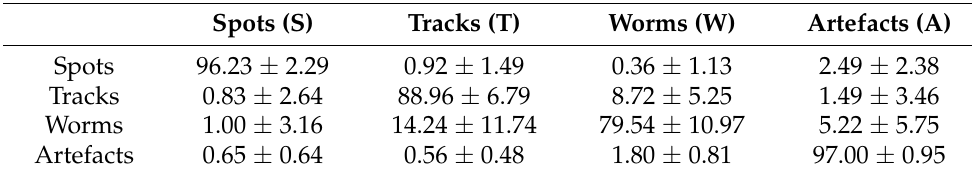
Table 9. Confusion matrix of the network with input VGG16 and threshold schema (8) t = 0.75. Data remaining = 74.26 ± 2.56 (S 63.12% ± 4.63%; T 55.60 ± 5.83; W 34.71 ± 7.93; A 96.46 ± 2.08), recognition rate = 94.95 ± 1.00.